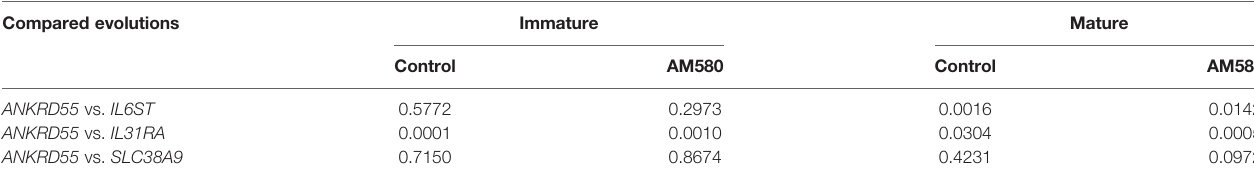
TABLE 1 | p -Values corresponding to the group-by-time interaction term ’ s signi fi cance in the adjusted generalized linear mixed univariable models. Compared evolutions